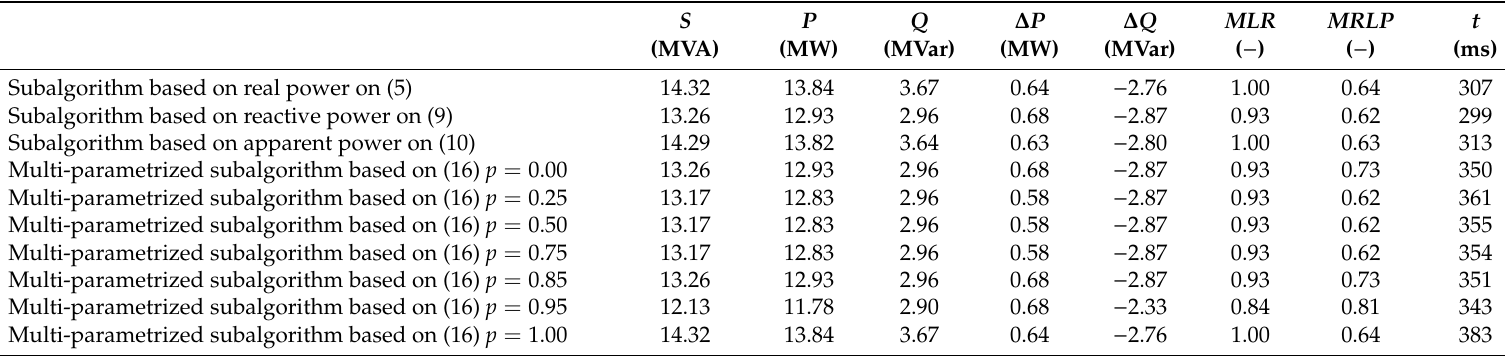
Table 5. Apparent power, real power, reactive power delivered to the considered 15 kV power system’s structure, changes of total real power and of total reactive